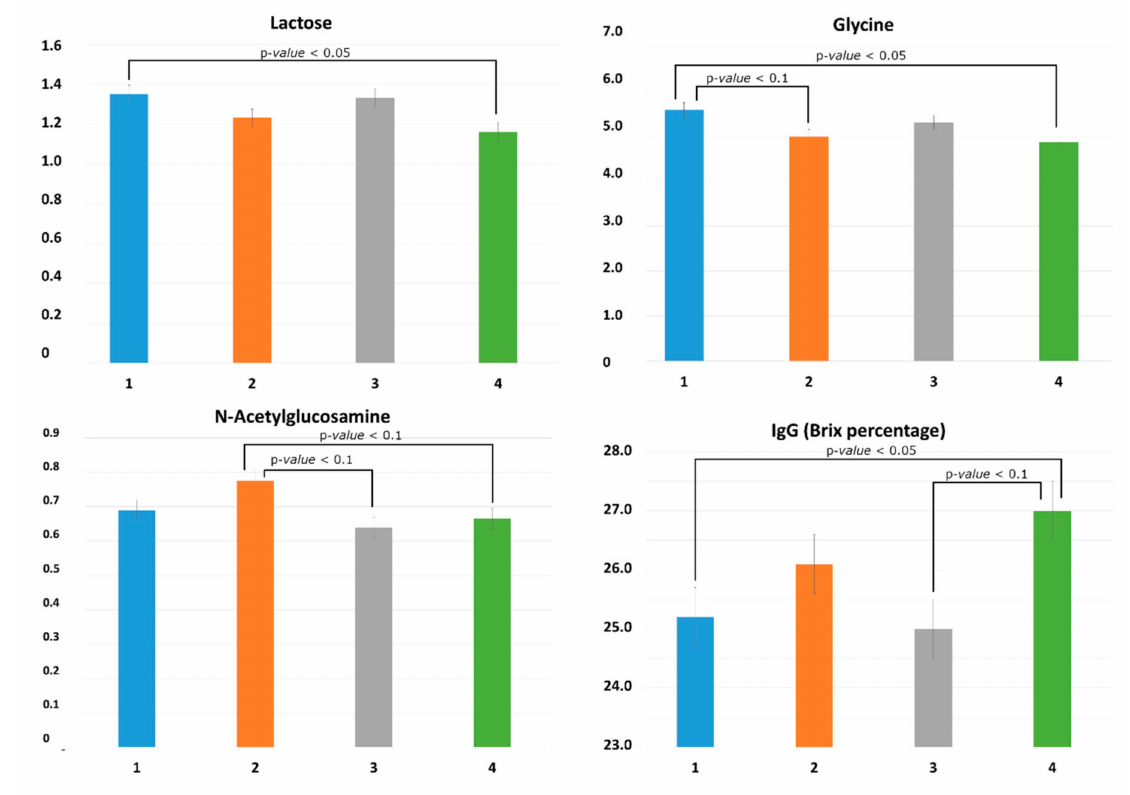
Figure 2. E ff ect of sow parity (PA) on metabolites and Brix percentage estimate of immunoglobulin G (IgG) in colostrum. Metabolite concentrations were considered in area arbitrary units; IgG concentration is expressed in Brix percentage. Lactose: PA1 vs. PA4, p < 0.05; glycine: PA1 vs. PA4, p < 0.05; PA1 vs. PA2, p < 0.1; N -acetylglucosamine: PA2 vs. PA3, p < 0.1; PA2 vs. PA4, p < 0.1; IgG: PA1 vs. PA4, p < 0.05; PA3 vs. PA4, p <